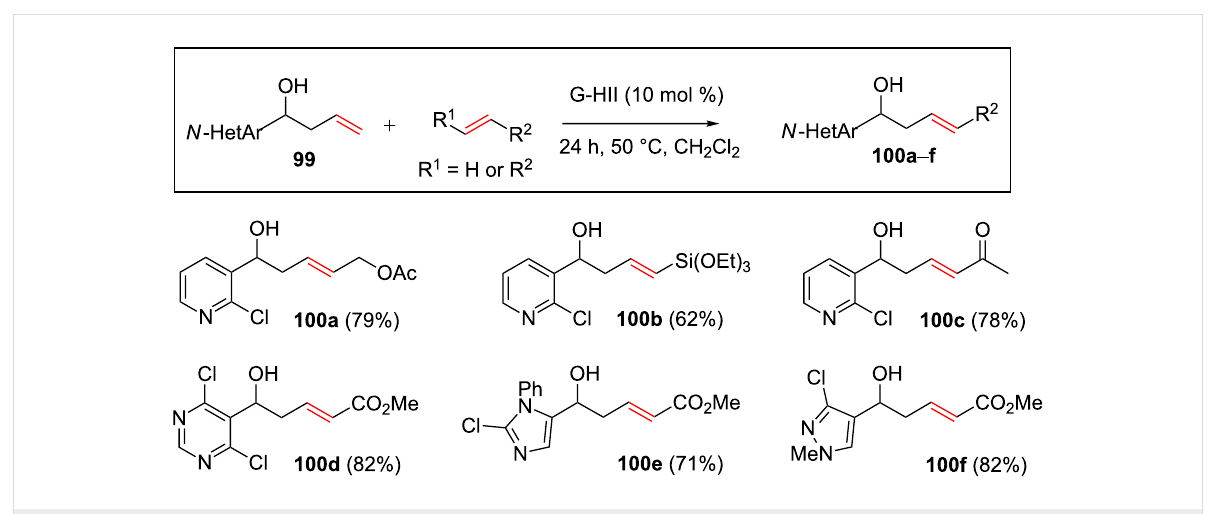
Scheme 36: Variation of the substituent on the pyridine ring.